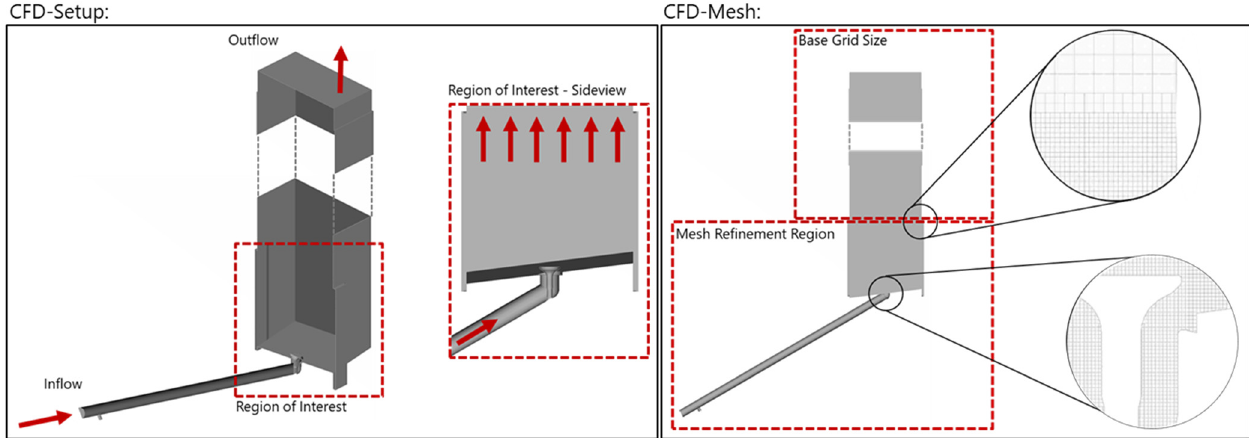
Figure 6. CFD-Domain with inflow and outflow ( left ) and mesh refinement regions of CFD-Domain ( right ).